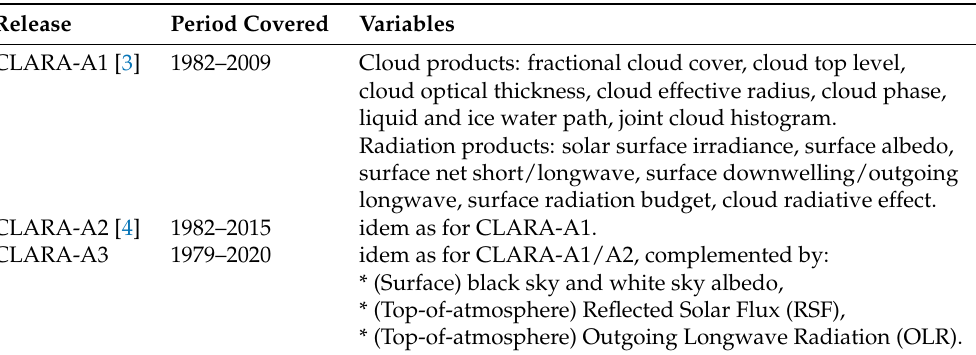
Table 1. CM SAF CLARA edition summary.